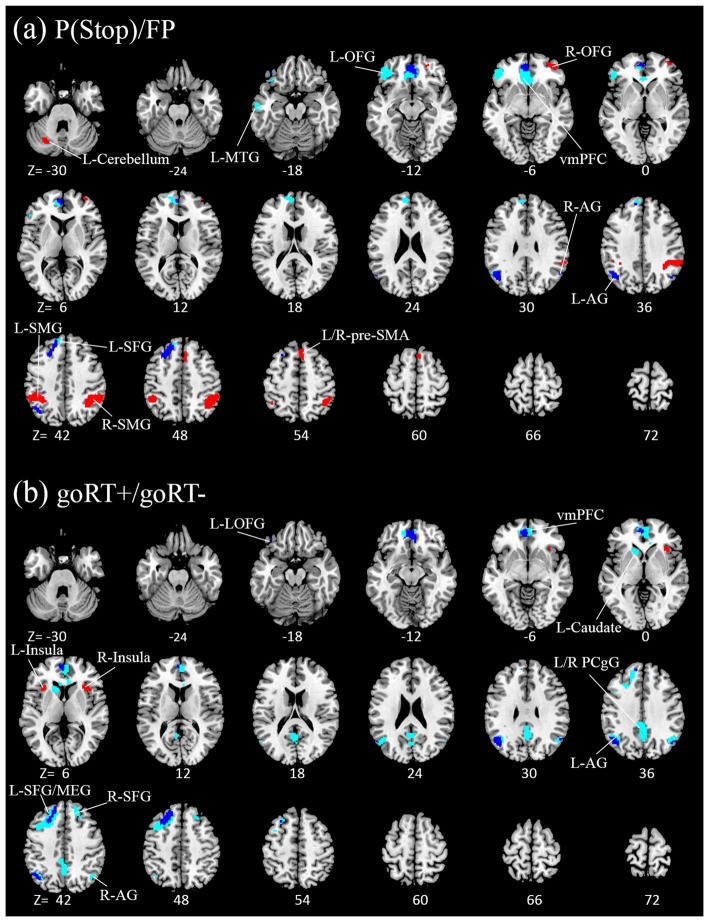
Regional activations to (A) stop signal anticipation (red) and motor preparation (blue) and to (B) go trial RT slowing (red) and speeding (blue). Clusters overlapped for motor preparation and goRT speeding. With exclusive masking, voxels distinct to motor preparation and goRT speeding are highlighted in light blue. Clusters are overlaid on a structural template in axial sections (from z = −30 to 72). P < 0.05, family wise error (FWE) corrected.